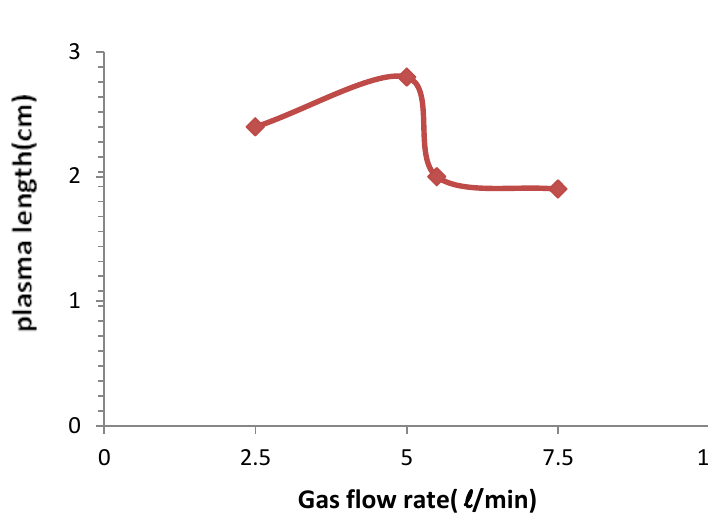
Fiq.3: Plasma jet length as a function of gas flow